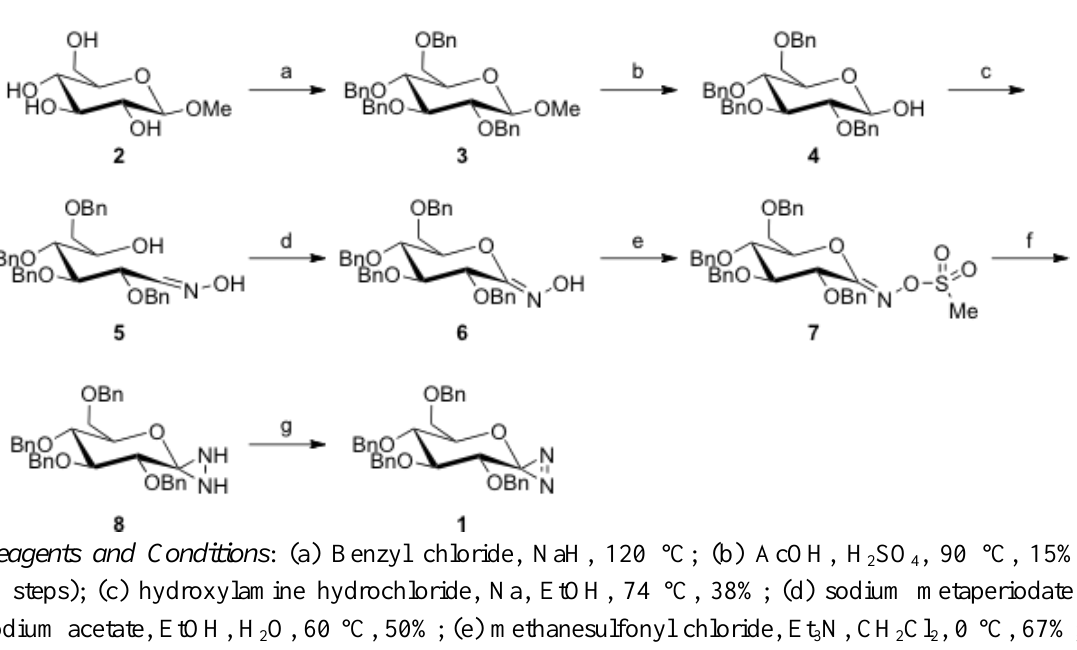
Scheme 1. Synthesis of glycosylidene diazirine 1